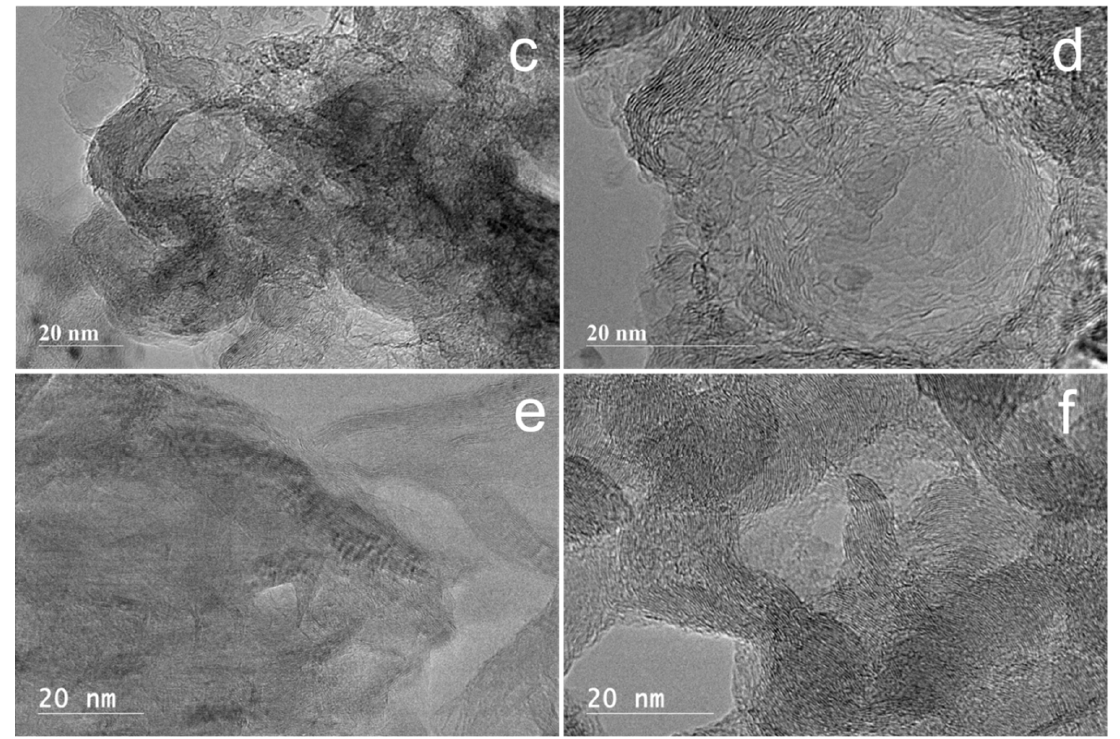
Figure 12. HRTEM images of the purified carbon materials from Ni@G samples after CDM reaction at 800 °C with different reaction time: Ni@G without CDM reaction ( a ), 30 min ( b ), 60 min ( c ), 120 min ( d ), 180 min ( e ), and 300 min ( f ).